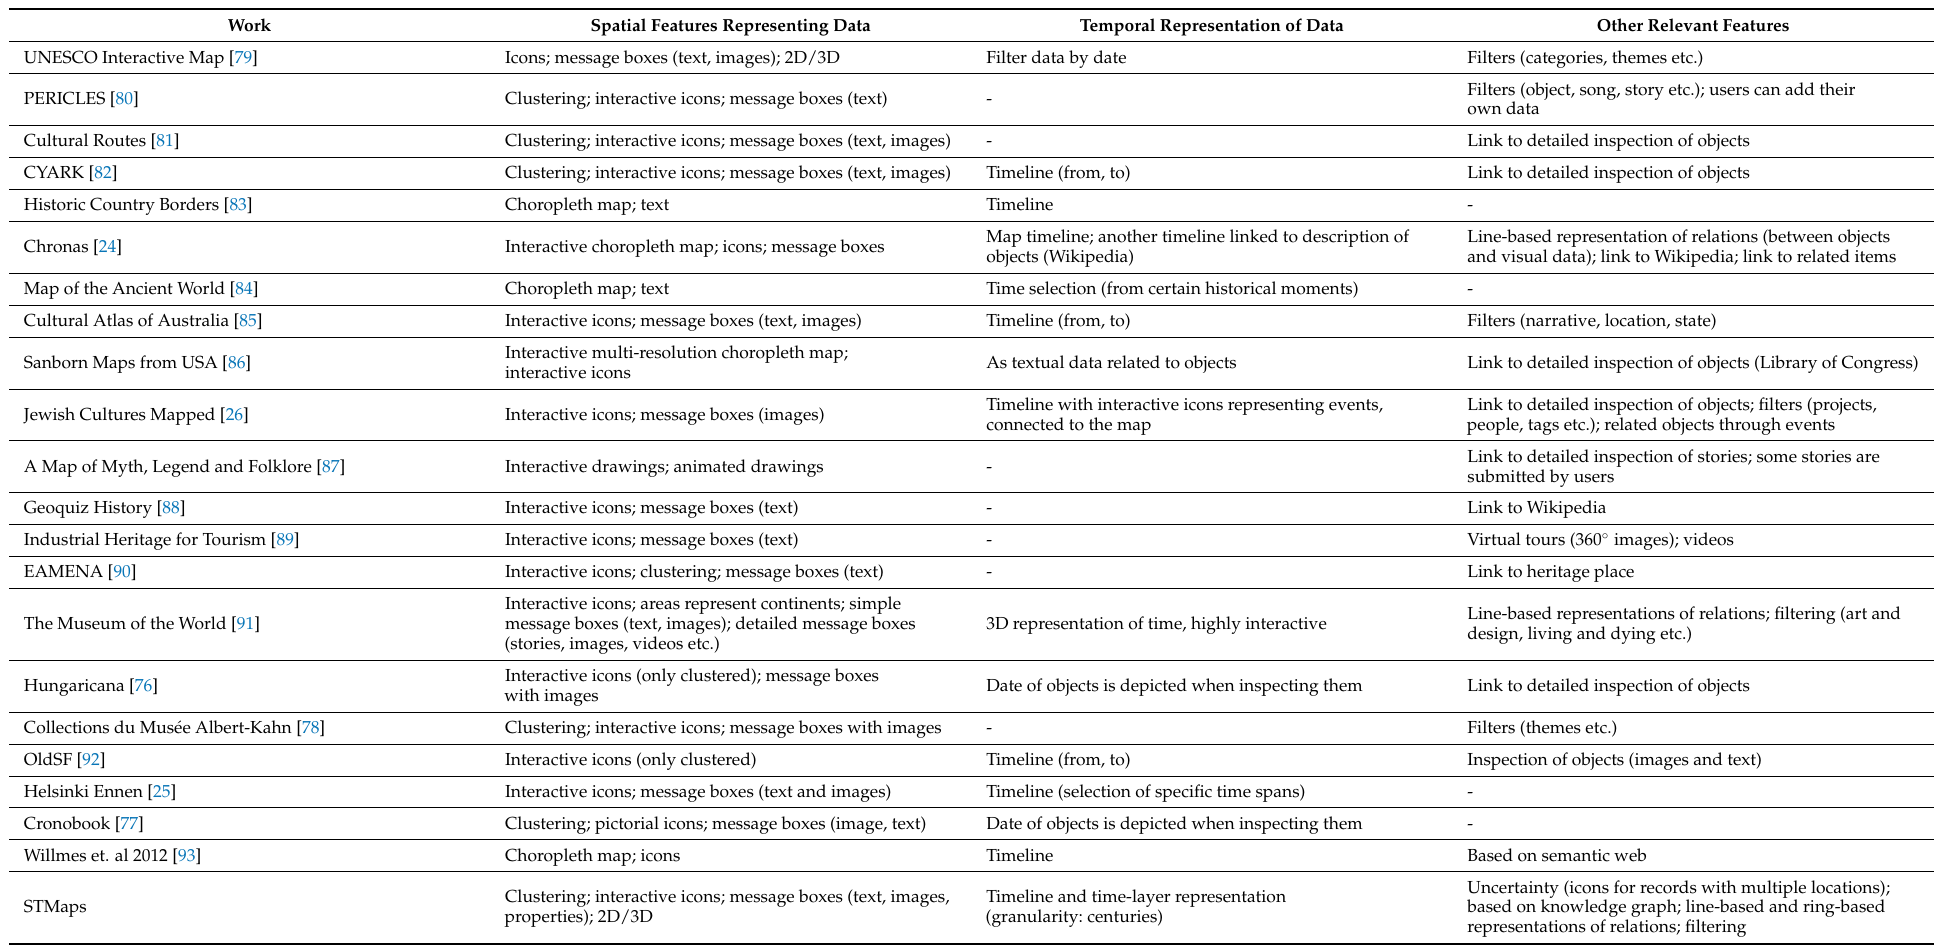
Table 3. Comparative analysis between STMaps and other related CH interactive